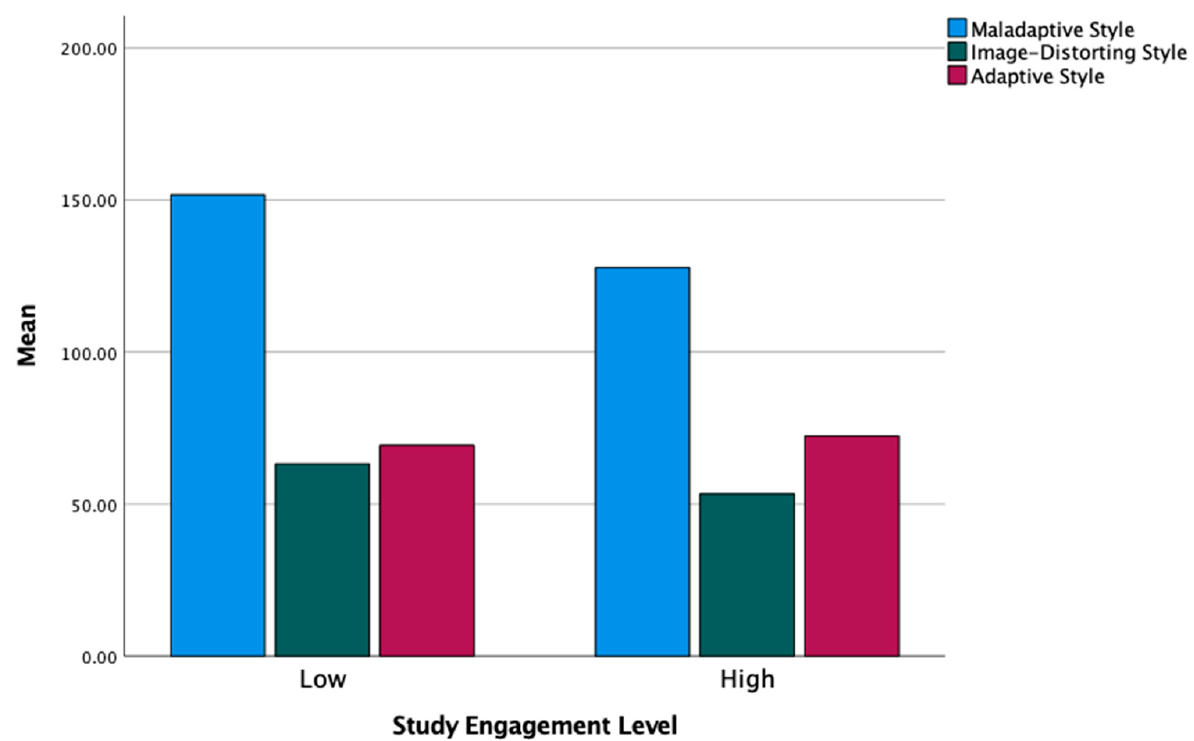
Figure 4. Mean levels of the three defense styles by low and high Study Engagement.